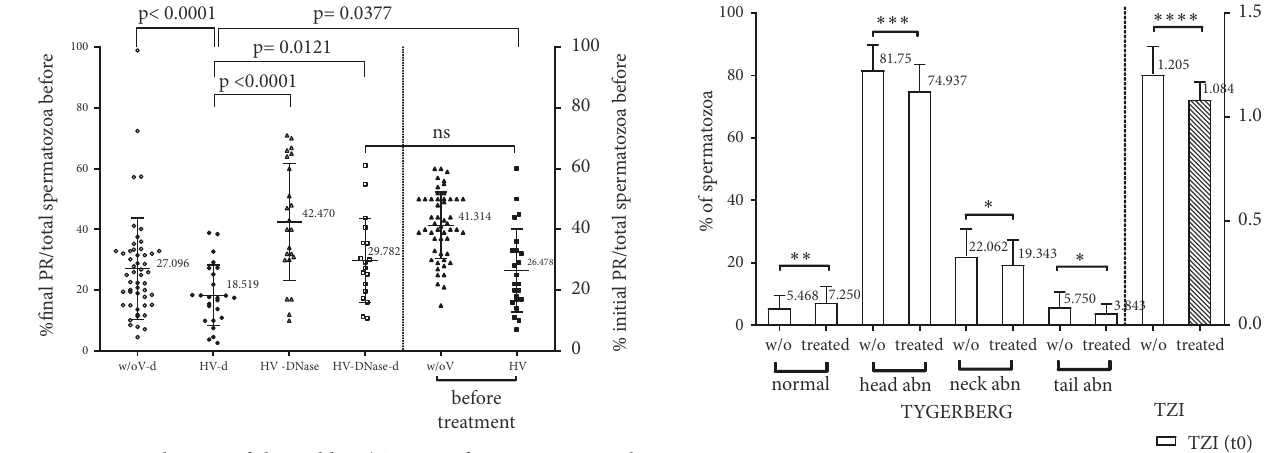
Figure 5: Evaluation of the yield % (TPMSC after treatment/total spermatozoa before treatment) of DGC, DNase treatment, and the combination of them, in semen with either high or normal viscosity. w/oV-d: semen with normal viscosity after DGC, HV-d: semen with high viscosity after DGC, HV-DNase: semen with high viscosity after DNase treatment, and HV-DNase-d: semen with high viscosity after DNase treatment, followed by DGC. w/oV: semen with normal viscosity before treatment; HV: semen with high viscosity before treatment.